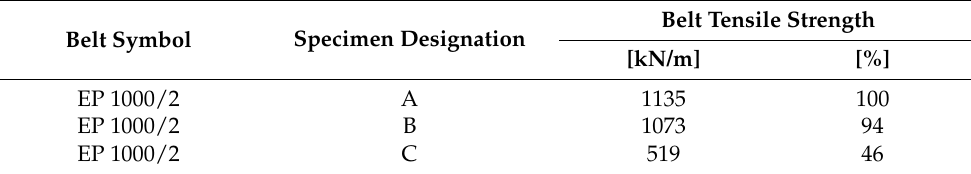
Table 4. Results of strength tests for specimens of belts A, B and